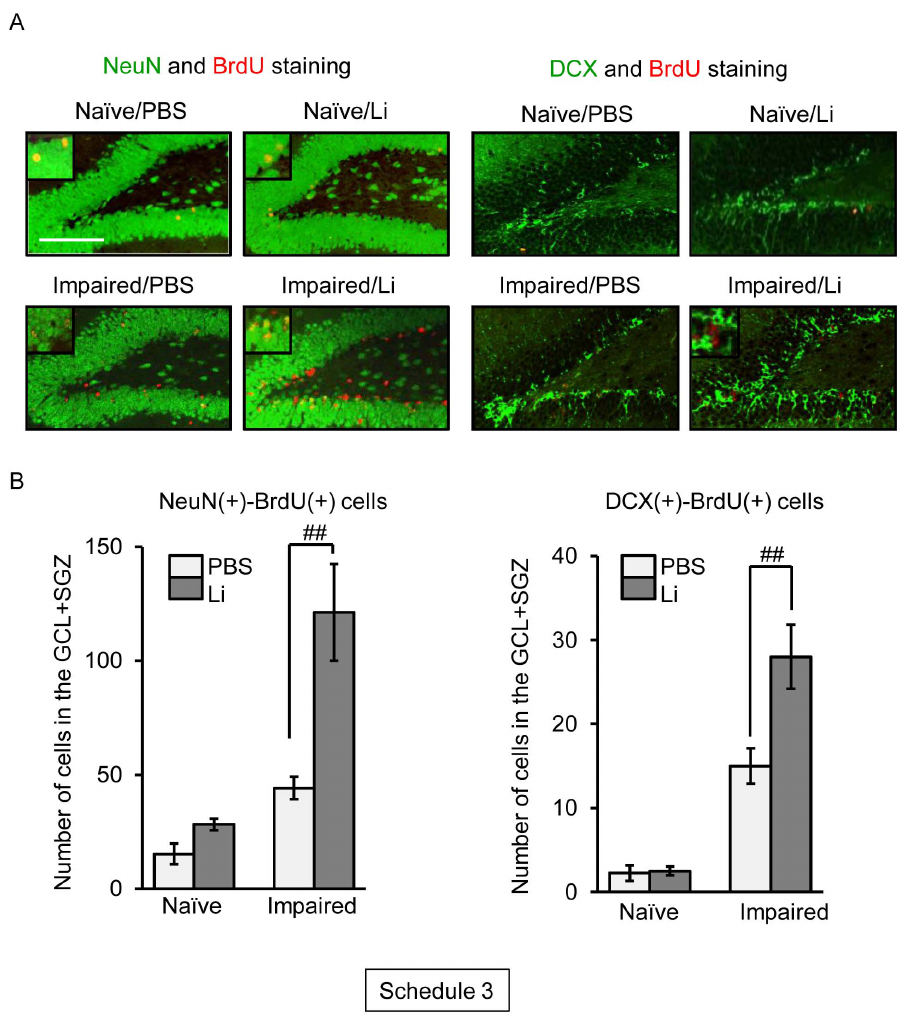
Figure 5. Effect of lithium (Li) on neuronal differentiation of BrdU( + ) cells generated following neuronal loss. Animals were given either lithium carbonate (100 mg/kg, i.p.) or PBS with BrdU on day 2 post-treatment with PBS or TMT, subsequently given once a day either lithium carbonate or PBS up to day 15, and then decapitated on day 30 post-treatment for preparation of sagittal hippocampal sections, which were then stained with antibodies against NeuN or DCX and BrdU (Schedule 3). ( a ) Fluorescence micrographs show NeuN( + ) cells ( green ) and BrdU( + ) cells ( red ) in the dentate gyrus of the 4 groups (naı¨ve/PBS, naı¨ve/Li, impaired/PBS, impaired/Li). Scale bar=100 m m ( b ) Graphs showing the numbers of NeuN( + )-BrdU( + ) cells and DCX( + )-BrdU( + ) cells in the GCL + SGZ of the 4 groups. Values are expressed as the mean 6 S.E., calculated from 4–11 animals. ## P , 0.01, significant difference between the values obtained for PBS and Li groups.